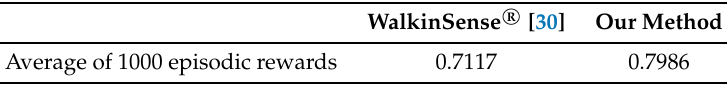
Table 1. Comparison of the different sensor placements.